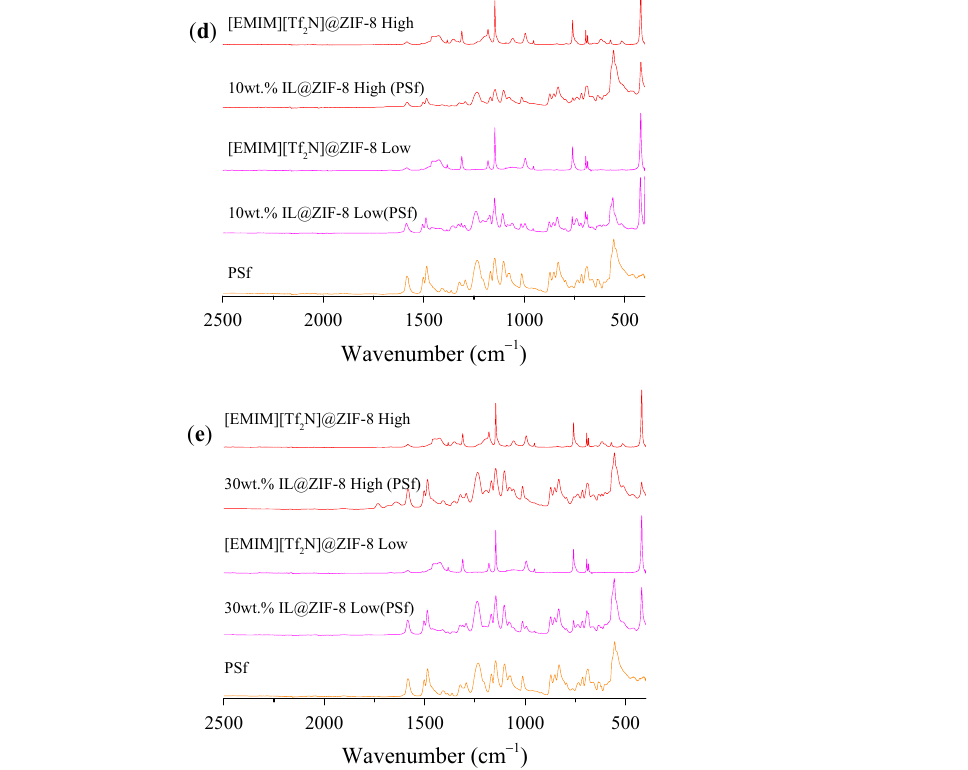
Figure A9. Normalized FT-IR spectra of PSf-based MMMs considering: ( a ) ZIF-8 (10 and 30wt.%); ( b ) 10wt.%[EMIM][DCA]@ZIF-8 composites (low and high) MMMs; ( c ) 10wt.%[EMIM][TCM]@ZIF-8 composites (low and high) MMMs; ( d ) 10wt.%[EMIM][Tf 2 N]@ZIF-8 composites (low and high) MMMs; and ( e ) 30wt.%[EMIM][Tf 2 N]@ZIF-8 composites (low and high) MMMs. Composites spectra were included as reference to each case. Table A5. Pure CO 2 , CH 4 and N 2 permeability at 303.15 K for all membranes prepared and tested in this work. Gas permeability error deviation was estimated from membrane